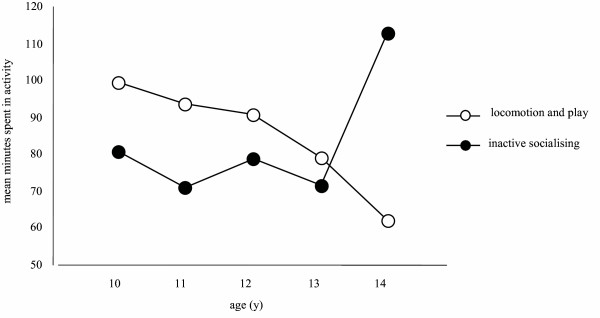
Change in minutes spent in loco-play compared to the change in minutes spent in inactive socialising with increasing age in years. Note: There were similar proportions of males and females in each age group.